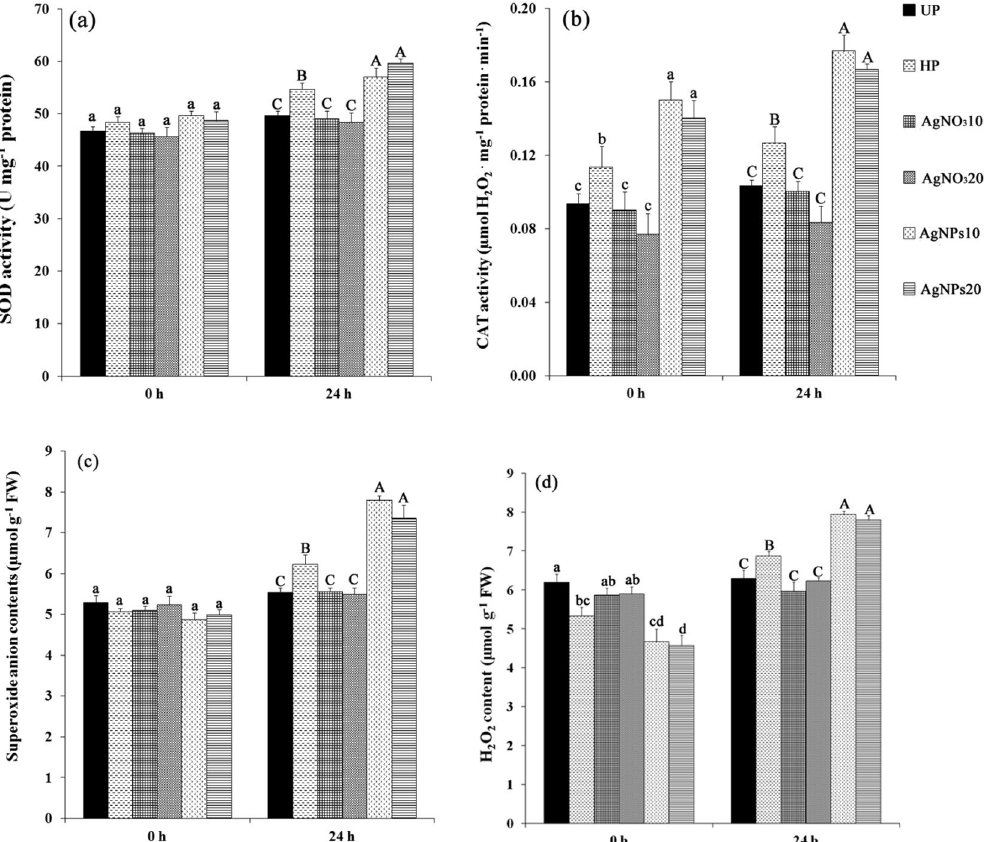
Figure 7. Antioxidant enzyme activities and ROS contents in rice seeds of different priming treatments compared with unprimed control. After priming and seeds were re-dried, activities of SOD ( a ), CAT ( b